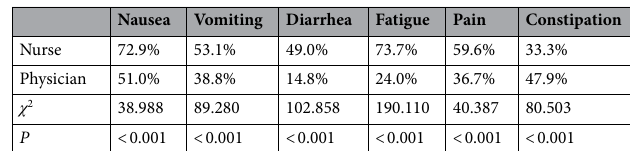
Table 2. Comparison of reporting rate between nurses and